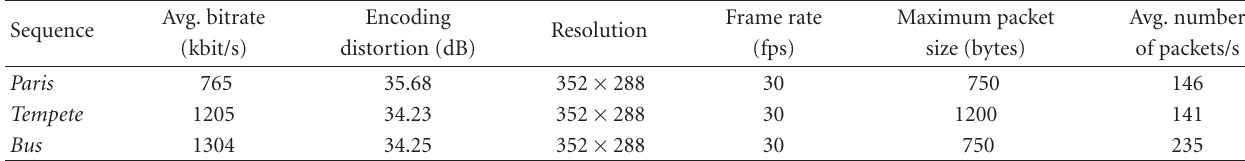
Table 1: Characteristics of the sequences used as H.264 streams.